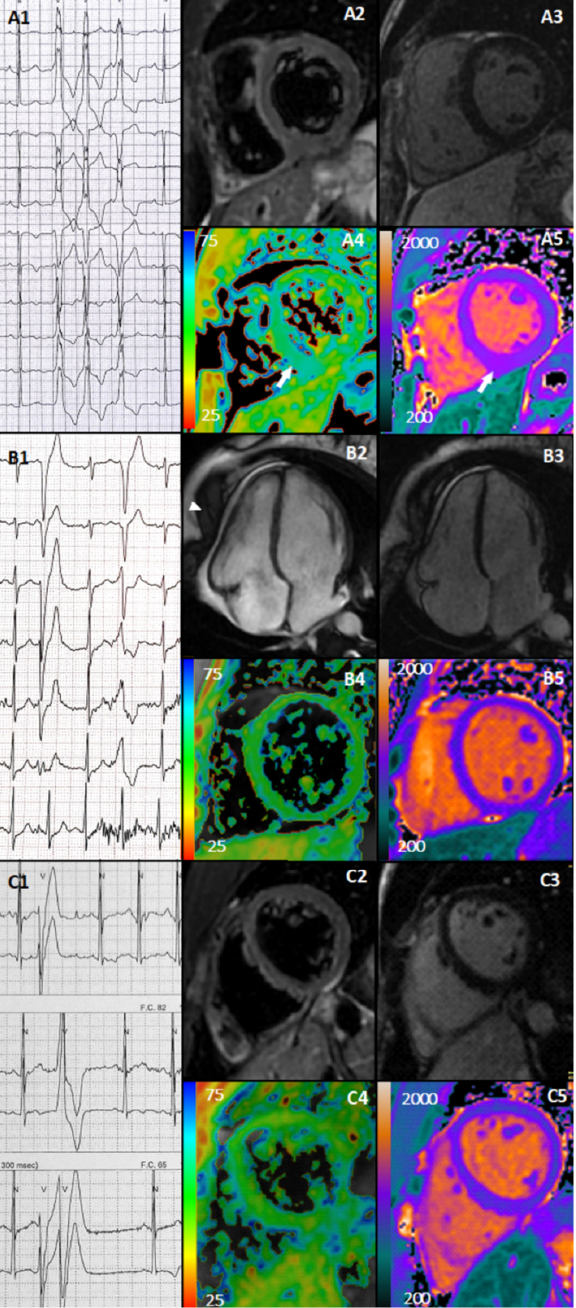
Figure 1. Newly detected abnormal findings. Case 1. Athletes presented with exercise ‐ induced NSVT with LBBB morphology, inferior axis and transition in V3 ( A1 ), negative T2 ‐ weighted ( A2 ), absence of LGE ( A3 ), increased T2 mapping ( A4 ), and native myocardial T1 mapping ( A5 ) at the mid ‐ inferior wall and inferior septum (white arrows). Case 2. Athlete presented with exercise ‐ induced polymorphic PVCs with LBBB morphology with transition in V6 (first one) and in V4 (second one) ( B1 ), cine CMR with mild pericardial effusion (arrows) ( B 2), negative LGE ( B3 ), normal T2 mapping ( B4 ), and T1 myocardial native mapping ( B5 ). Case 3. Athlete presented with exercise ‐ induced polymorphic PVCs, often R on T, and a couplet ( C1 ) and negative T2 ‐ weigthed sequence ( C2 ), negative LGE ( C3 ), normal T2 mapping ( C4 ), and native myocardial T1 mapping ( C5 ).